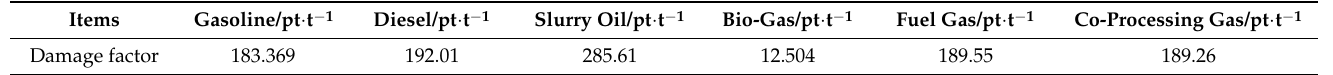
Table 5. Damage factors of output streams: products.